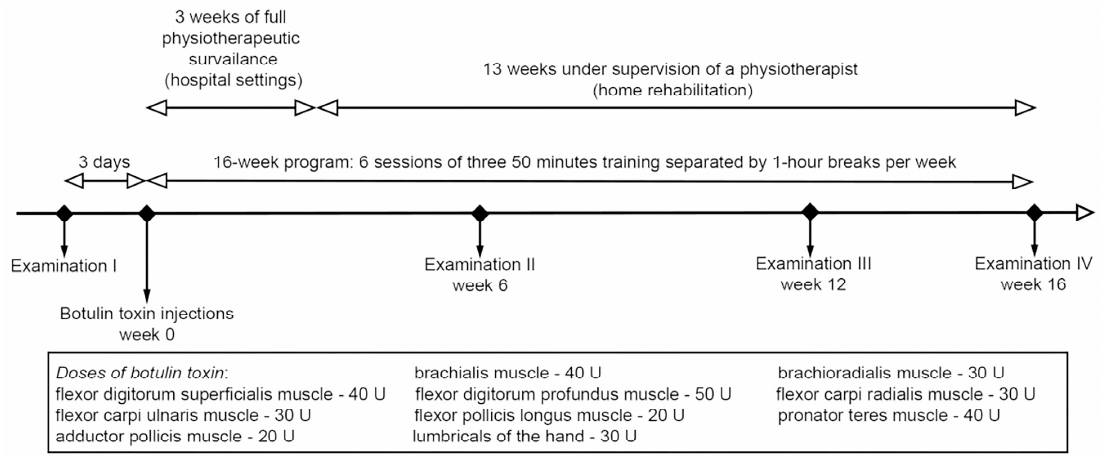
Figure 1. Study design. Created in Photoshop release 24.1.1 (Adobe, San Jose, CA, USA).